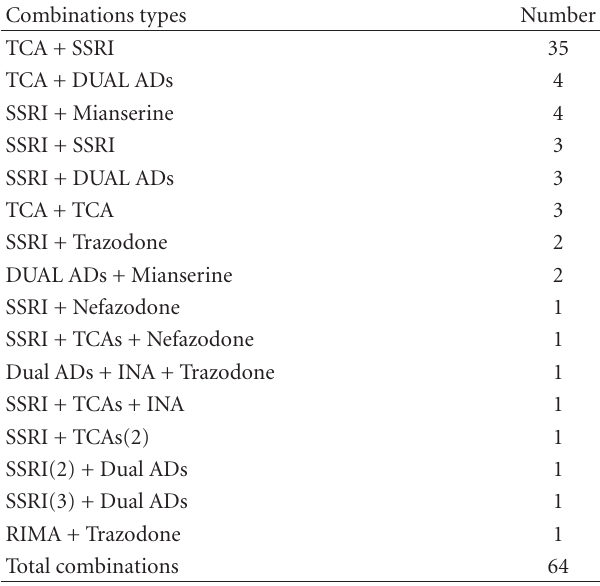
Table 6: Combinations